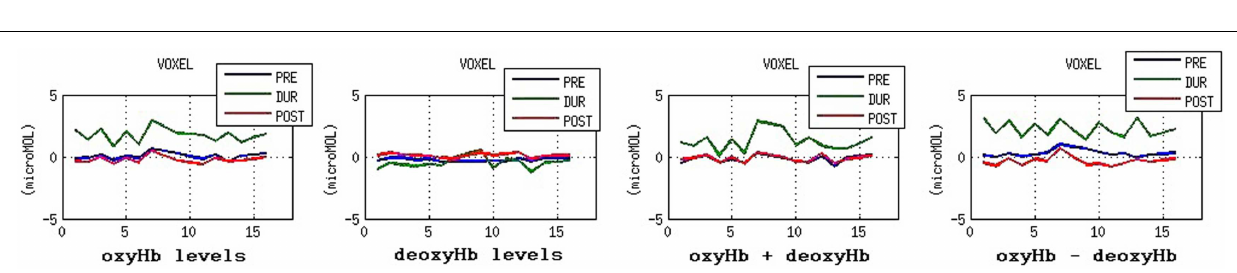
FIGURE 4 | Frontal hemodynamic responses in schizophrenia patients before (pre), during, and after (post) KB through all the 16 voxels . Abbreviations: oxyHb, oxygenated hemoglobin; deoxyHb, deoxygenated hemoglobin; totalHb, total hemoglobin; KB, kapalabhati.